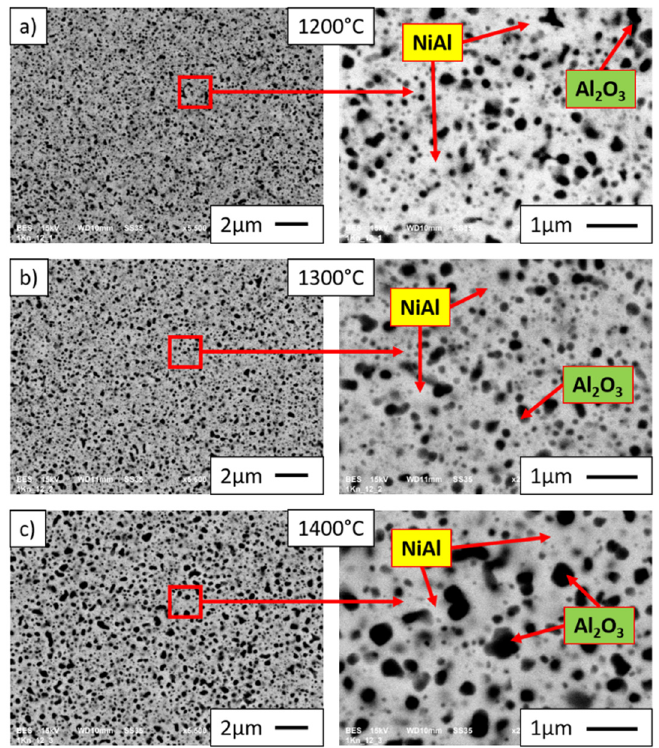
Figure 11. SEM images of microstructures of NiAl-10%Al 2 O 3 samples after sintering by PPS at ( a ) 1200 °C, ( b ) 1300 °C, and ( c ) 1400 °C.